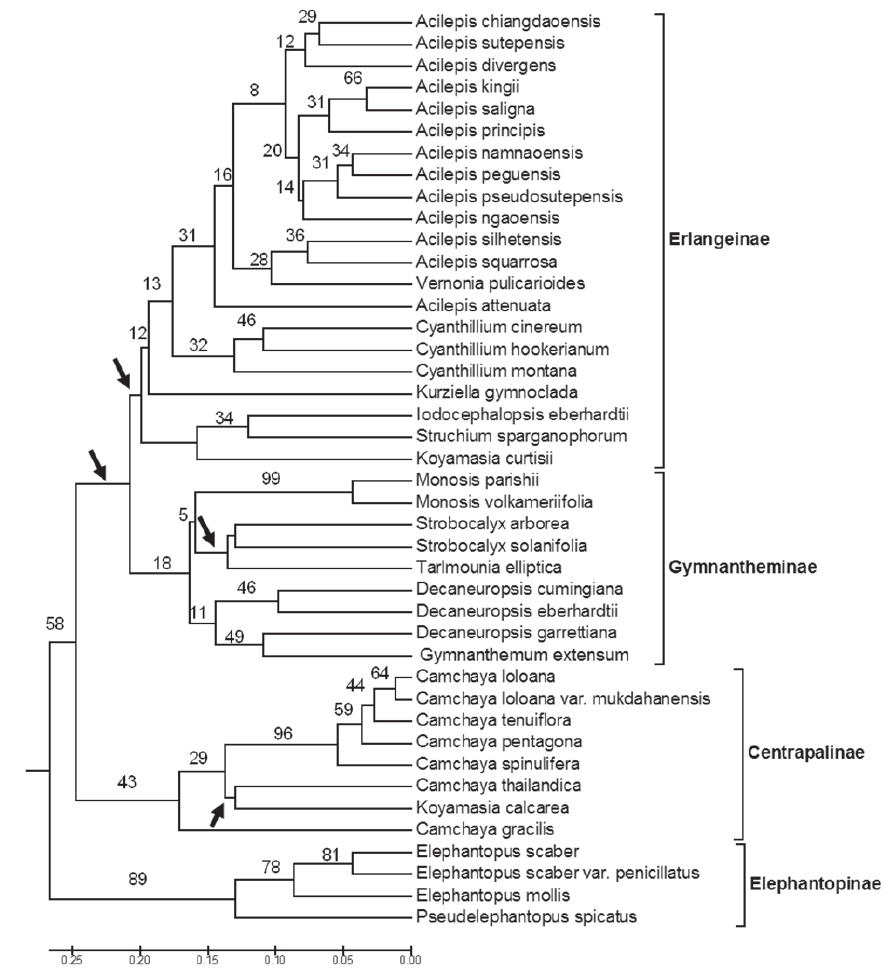
Figure 4. UPGMA tree for 42 Thai Vernonieae based on vegetative, reproductive and pollen morphology (see Table 2, Figs 1, 2, 3). Number above the lines indicate bootstrap support (1000 replications). Zero length branches indicated by